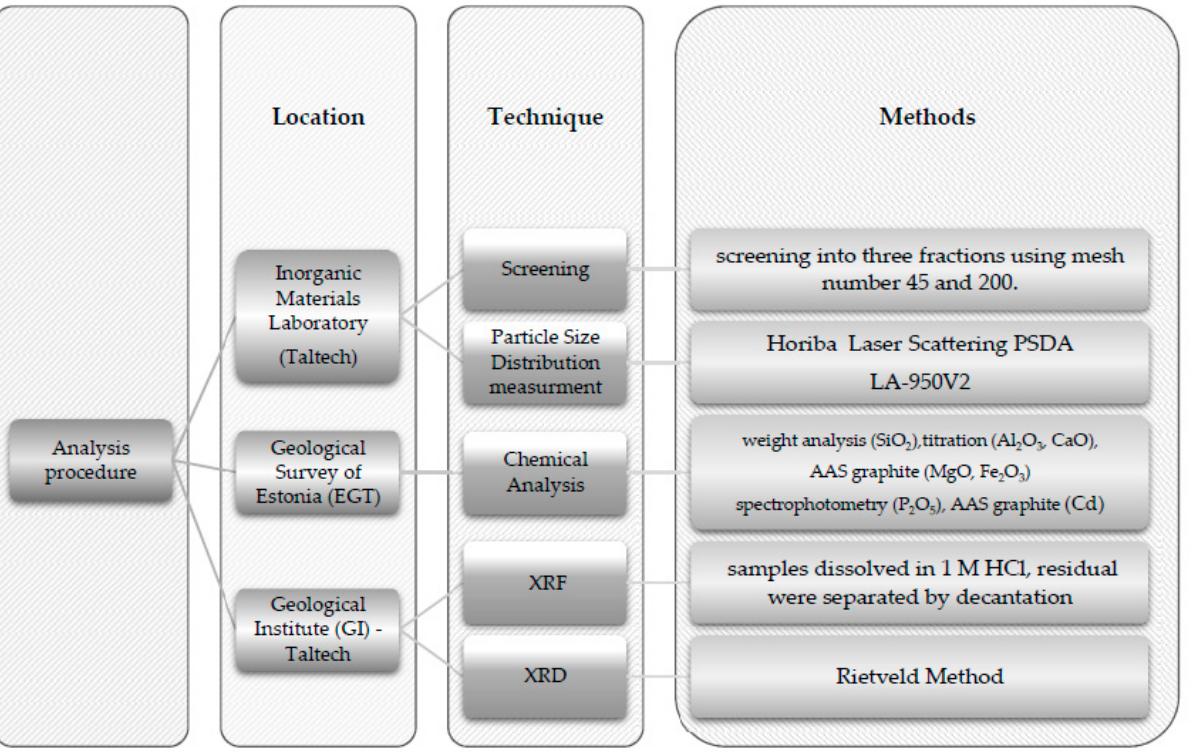
Figure 2. Analysis method of the obtained samples (Phase 2).